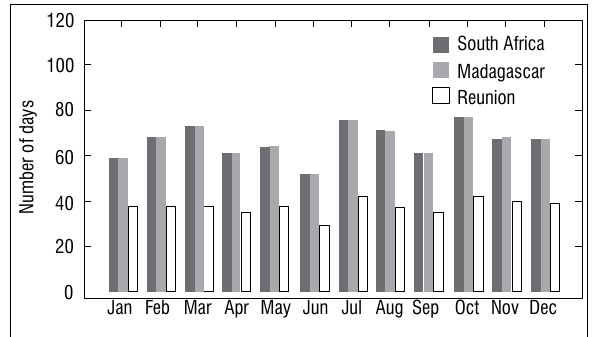
The number of satellite overpass days during each month for the three study